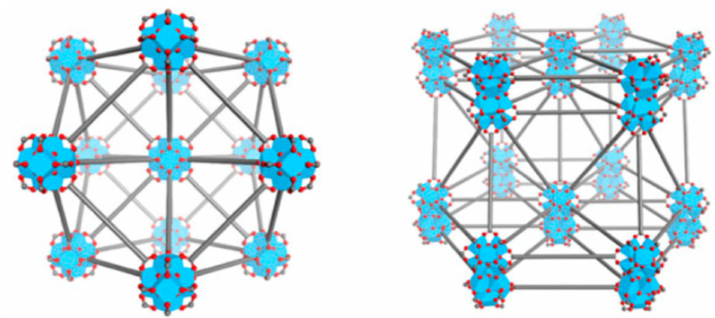
Figure 5. Structural representations of Hf 6 -DBA or Hf 6 -DBAn (left) and Hf 12 -DBA or Hf 12 -DBAn